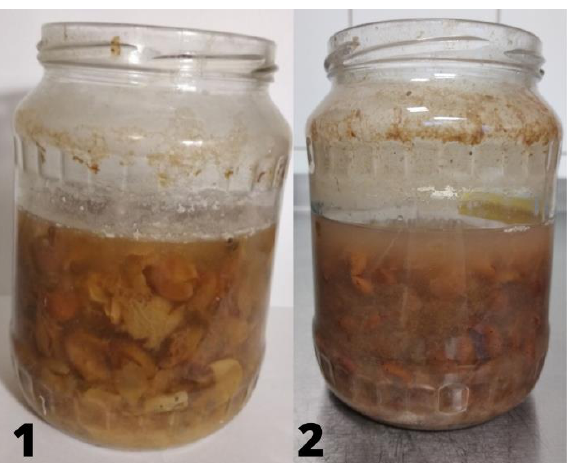
Figure 2. Grape vinegar samples after 1st and 2nd month of fermentation.